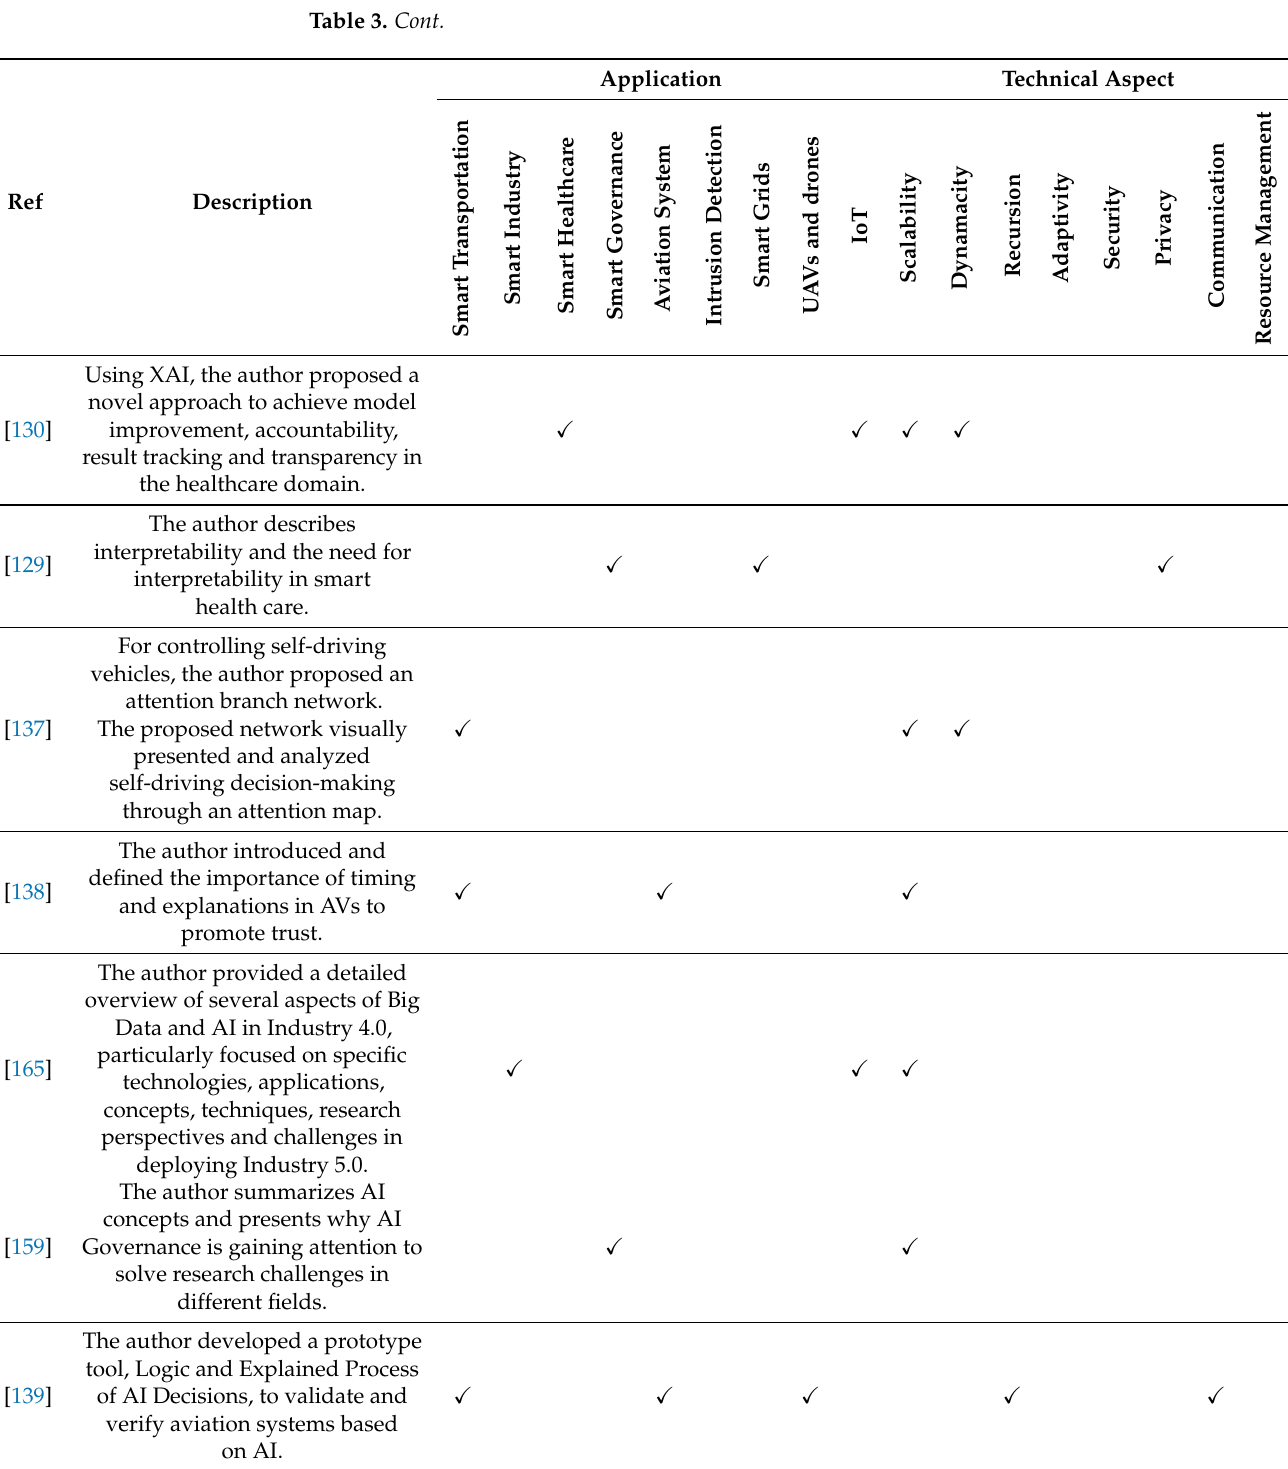
Table 3. Cont. Application Technical